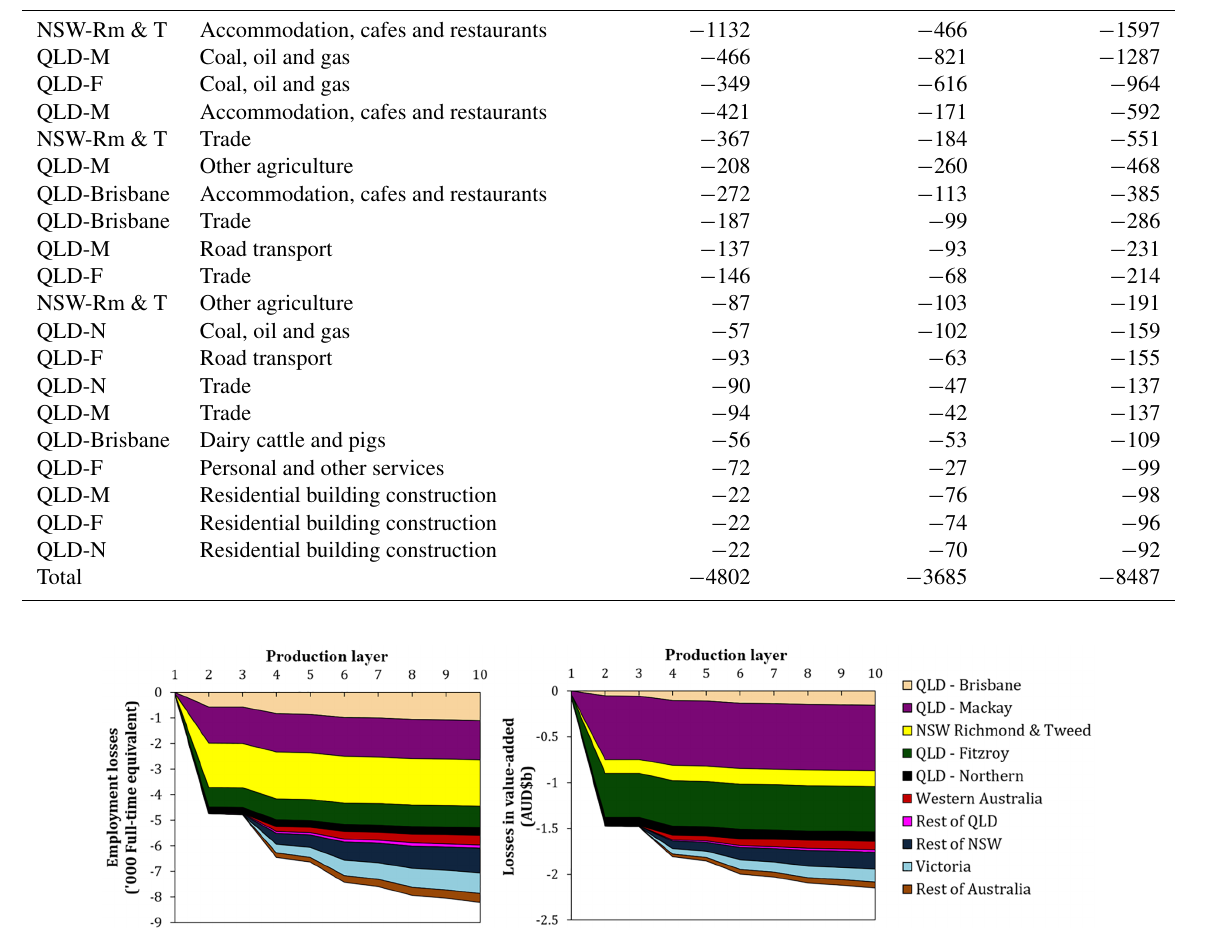
Table 4. Direct, indirect and total employment affected by Cyclone Debbie, by state and sector. Region